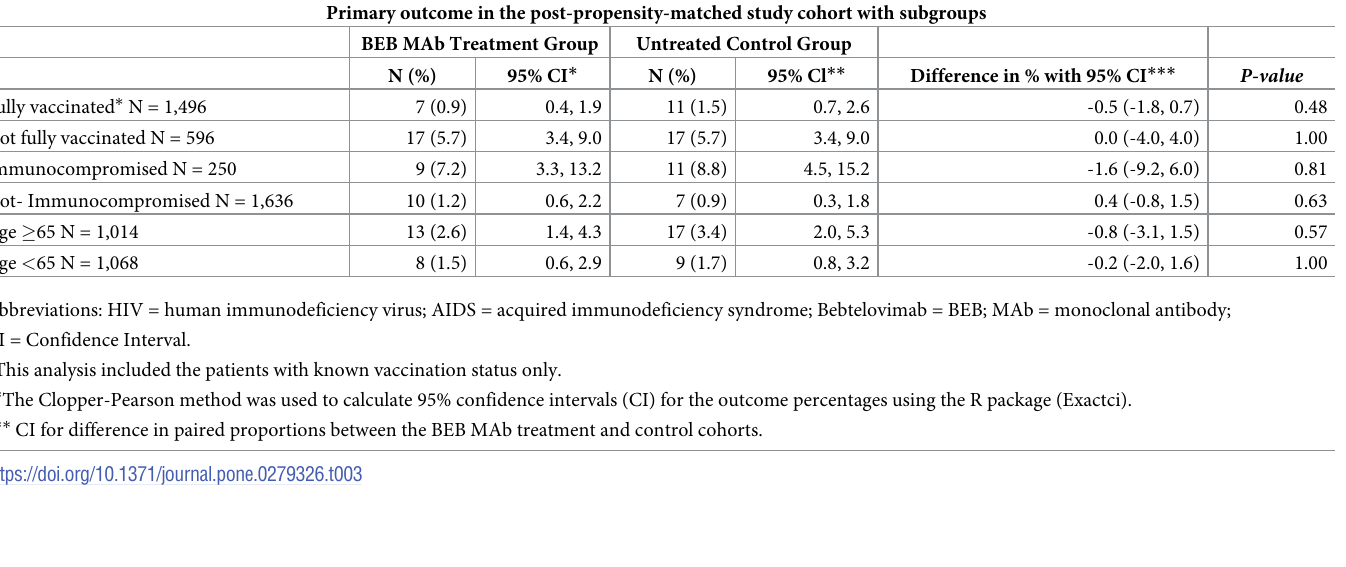
Table 3. Subgroup analysis for the primary composite outcome stratified by patient vaccination status (fully vaccinated vs. not fully vaccinated), age category (age < 65 vs. age � 65), and immunocompromised status (comorbidities including HIV/AIDS or solid organ transplants or malignancy) between the propensity matched Bebtelovimab (BEB) and untreated control